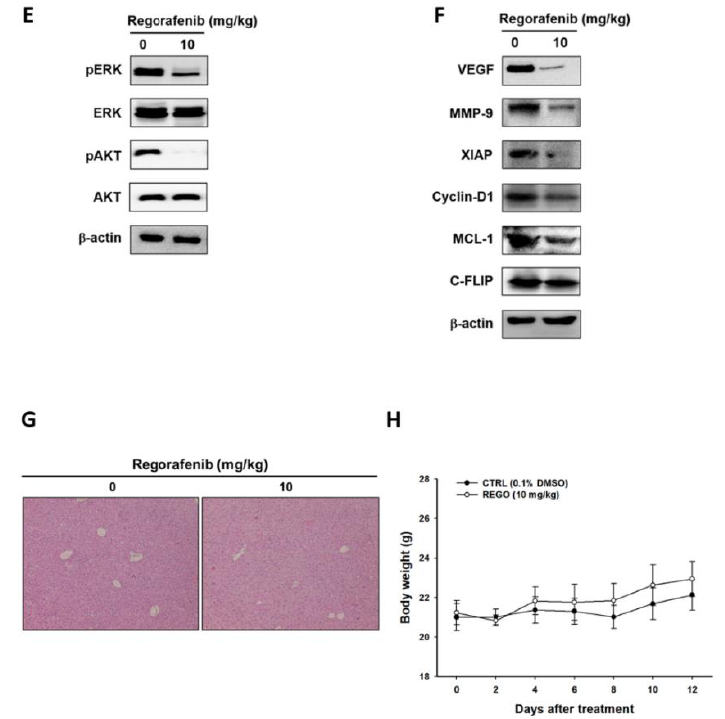
Figure 5. Tumor growth was suppressed by regorafenib treatment. ( A ) Experimental flow chart of animal study. ( B ) Tumor size measured by caliper from day 0 to day 12. ( C ) Bioluminescent imaging (BLI) of each group on day 0 and day 14 after treatment. ( D ) Photon intensity quantification bar chart of each group. ( E ) Ex vivo Western blot result of ERK and AKT. ( F ) Protein level of VEGF, MMP-9, XIAP, CyclinD1, MCL-1 and C-FLIP which were extracted from mice tumor tissue. ( G ) Hematoxylin and eosin (H&E) stain of liver tissue. ( H ) Body weight record of mice of every two days during therapy. * p < 0.05 and ** p < 0.01 vs. CTRL.